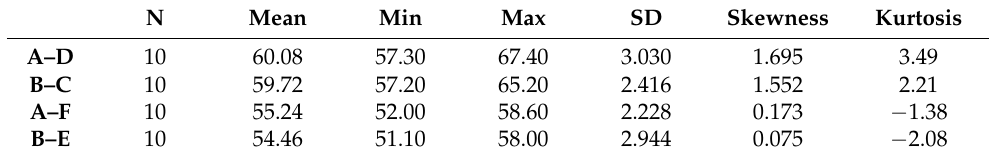
Table 2. Basic statistics of the measurement features of the maxillary ridge structures—control group. N